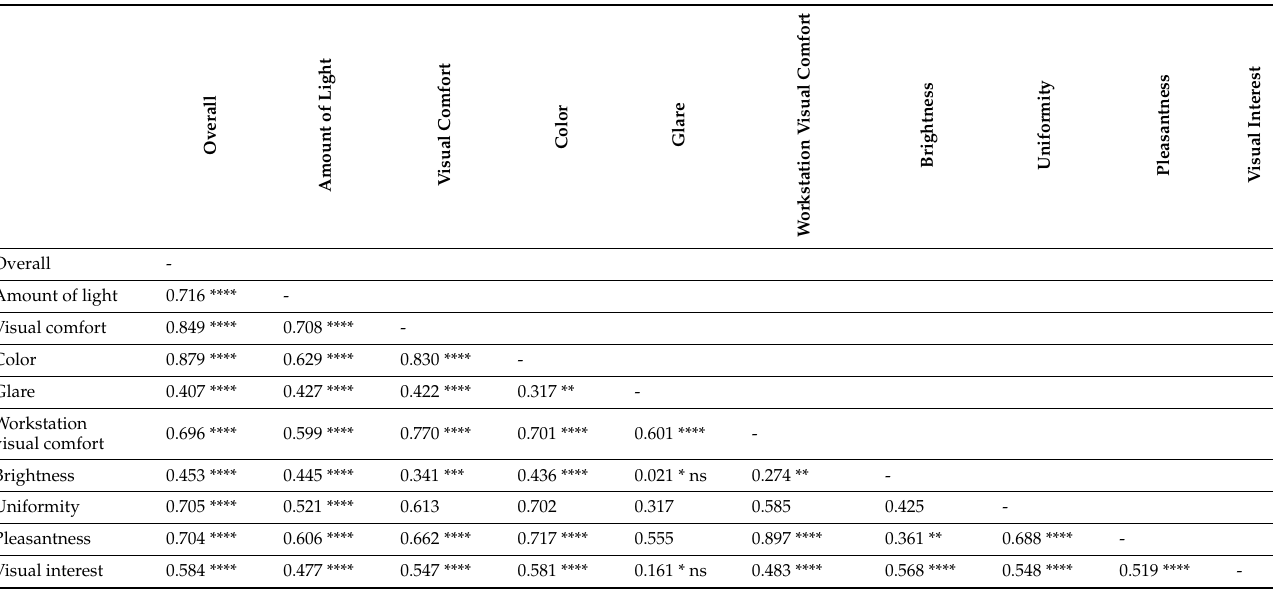
Table 5. The Spearman Correlation ( r s ) between the 10 Items in the lighting satisfaction EMA. Participants’ subjective responses to overall lighting satisfaction and visual comfort were highly correlated, as were responses to workstation visual comfort and overall pleasantness. Asterisks (*, **, ***, and ****) indicate p -values < 0.05, 0.01, 0.001, and 0.0001, respectively. Ns indicates not